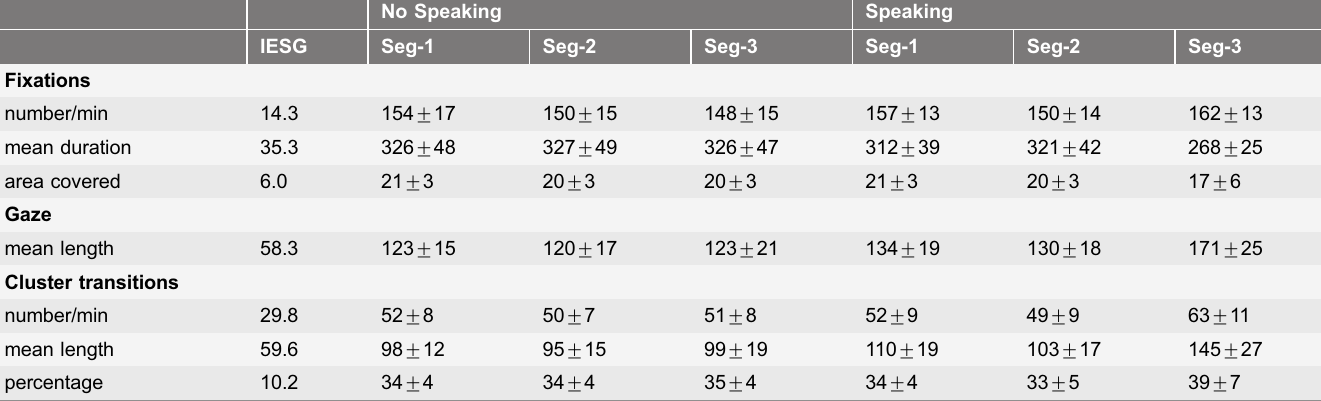
Table 1. Speaking effects on fixations, saccade lengths and cluster